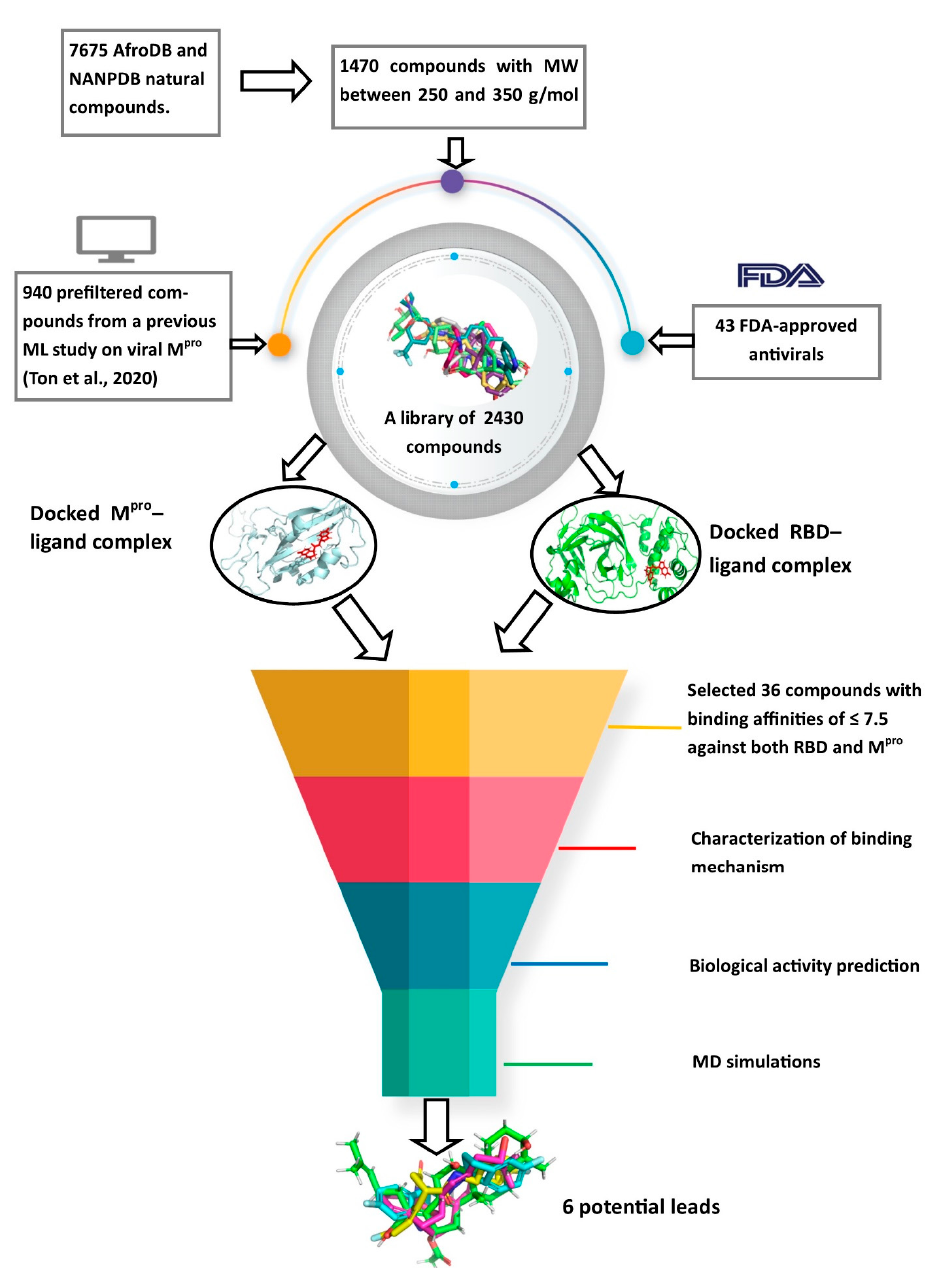
Figure 9. Methodology schema employed in the cheminformatics studies for predicting potential anti-SARS-COV-2 compounds. Natural compounds from the African Natural Product Database (AfroDB), North African Natural Product Database (NANPDB), the Food and Drug Administration (FDA)-approved antivirals and compounds from previous machine learning (ML) studies were docked against SARS-CoV-2 receptors M pro and RBD. Molecular weights (MW) were used to prefilter the molecules. Compounds with binding affinities of ≤− 7.5 kcal/mol against both receptors were selected for the downstream analysis. Methods include the characterizations of the protein-ligand complexes, biological activity predictions and MD